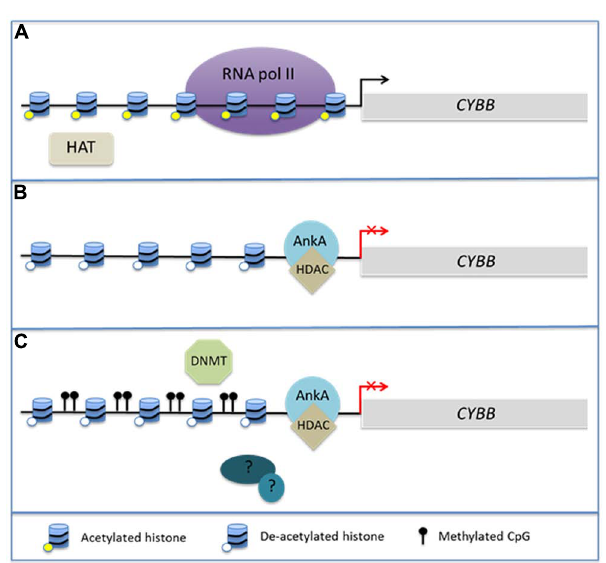
FIGURE 1 |AnkA alters chromatin structure at the CYBB promoter. During Anaplasma phagocytophilum infection, AnkA accumulates in the host cell nucleus where it can directly bind DNA and influence the transcription of CYBB , which encodes the gp91 phox component of the NADPH oxidase. (A) In the absence of infection, CYBB is activated by inflammatory signals and is easily transcribed. (B) During infection, AnkA binds the proximal promoter and recruits HDAC which deacetylates nearby histones in order to inhibit transcription. (C) We propose that additional host or bacterial-derived chromatin modifying enzymes, such as DNMT methylation of host CpGs, may also be involved in altering the host epigenome to the bacterium’s